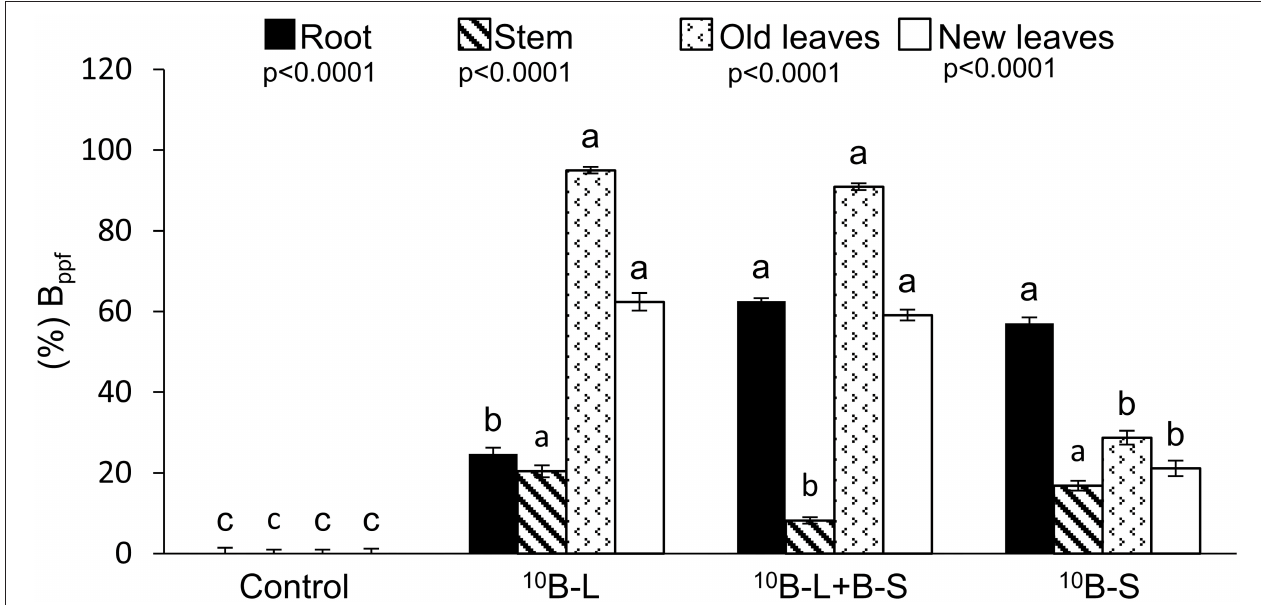
FIGURE 4 | Percentage of B fertilizer in the plant (%B ppf ) in the roots, stems, old leaves (pulverized part), and new leaves in different treatments. Control, without boron fertilization on the substrate (growth media) and leaves; 10 B-L, without B on the substrate (growth media) and with 10 B via the foliage; 10 B-L + B-S, fertilization with B on the substrate (growth media) and 10 B via the foliage; 10 B-S, fertilization with 10 B on the substrate (growth media) and without fertilization with B via the foliage. Error bars represent the standard errors of the means. Lowercase letters indicate significant differences among treatments, according to Tukey’s test at a 5% probability level. Values are presented as mean ±